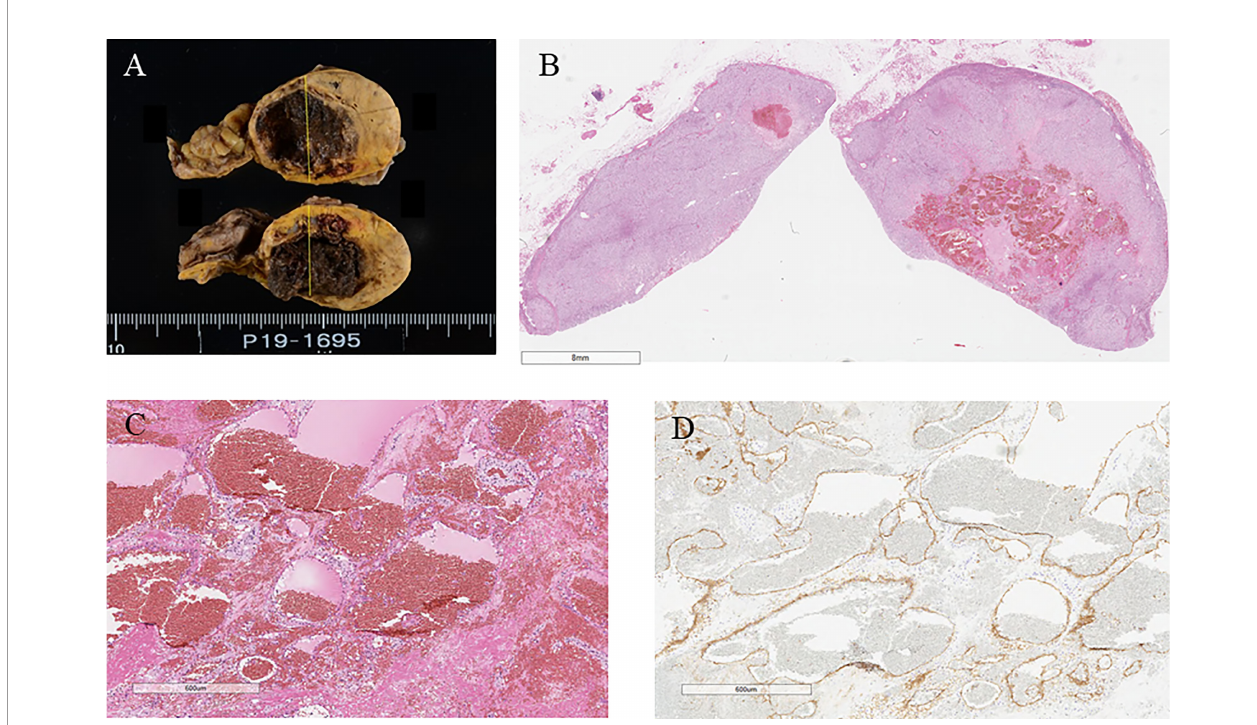
FIGURE 2 | (A) Surgical specimen showing hemorrhage in the adrenal tumor. (B) Hematoxylin and eosin-stained tumor section showing hemorrhage in the tumor. (C) Hematoxylin and eosin-stained section on high magni fi cation showing hemorrhage without vasculitis and ominous fi ndings of infection (40×). (D) CD31 immunostaining